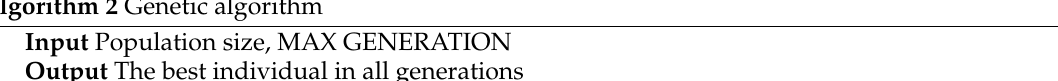
Algorithm 2 Genetic